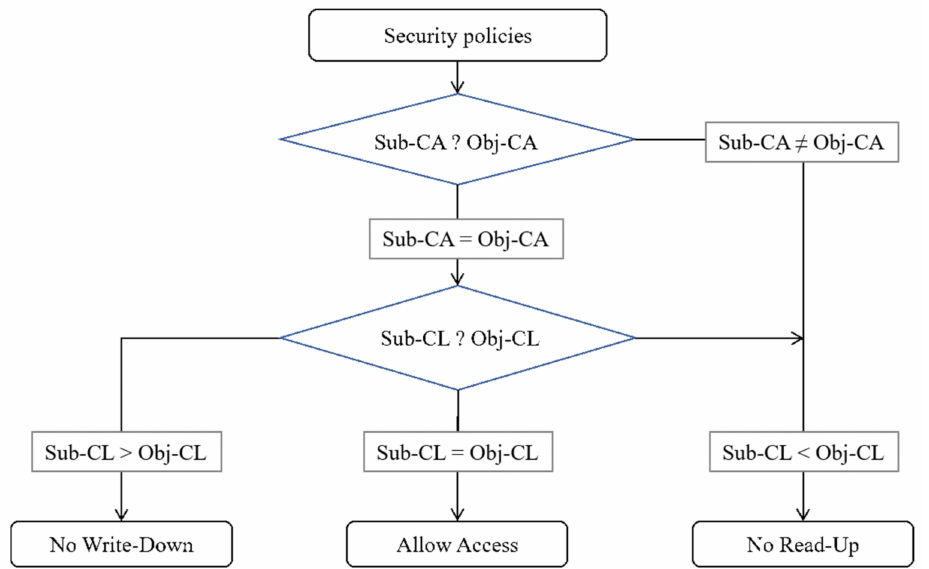
Figure 10. Security comparison algorithm.